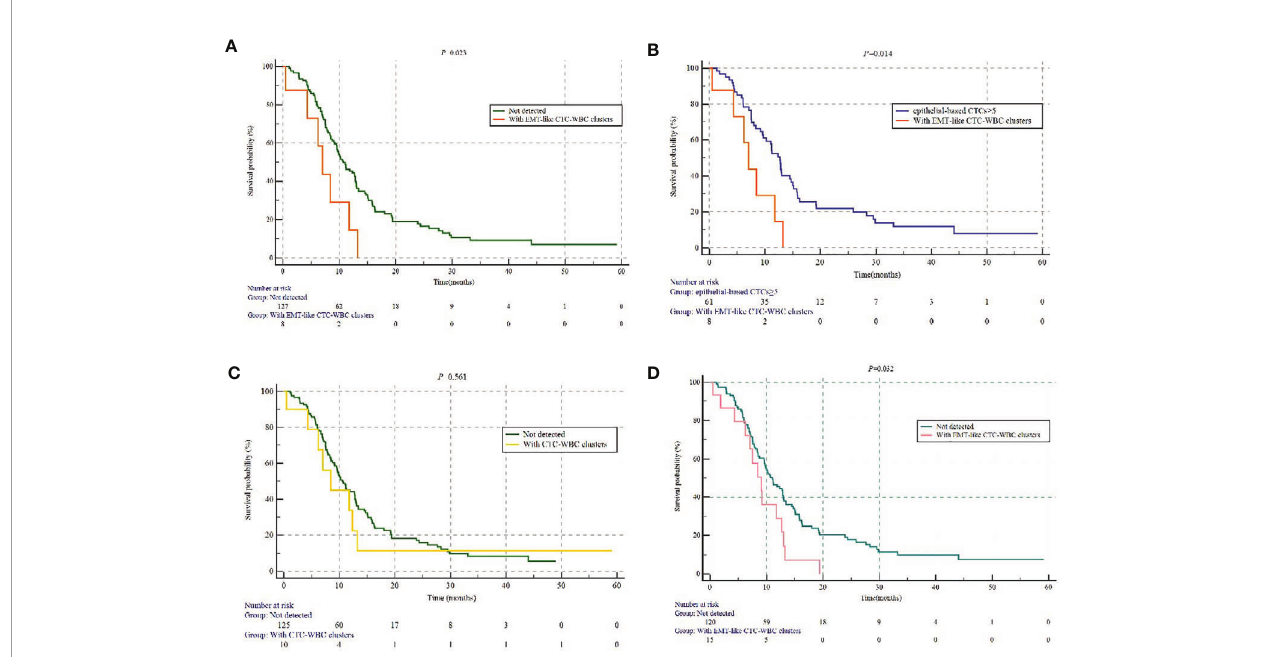
FIGURE 3 | The prognostic value of different subtypes of CTC-WBC clusters. (A) Kaplan-Meier analysis-based estimation of PFS probabilities of comparing the patients with at least one EMT-like CTC-WBC clusters to those without. (B) Kaplan-Meier analysis-based estimation of PFS probabilities of comparing the patients with at least one EMT-like CTC-WBC clusters to those to fi ve or more epithelial-based CTCs. (C) Kaplan-Meier analysis-based estimation of PFS probabilities of comparing the patients with at least one CTC-WBC clusters to those without. (D) Kaplan-Meier analysis-based estimation of PFS probabilities of comparing the patients with at least one EMT-like CTC-WBC clusters within 6 weeks after the start of chemotherapy to those